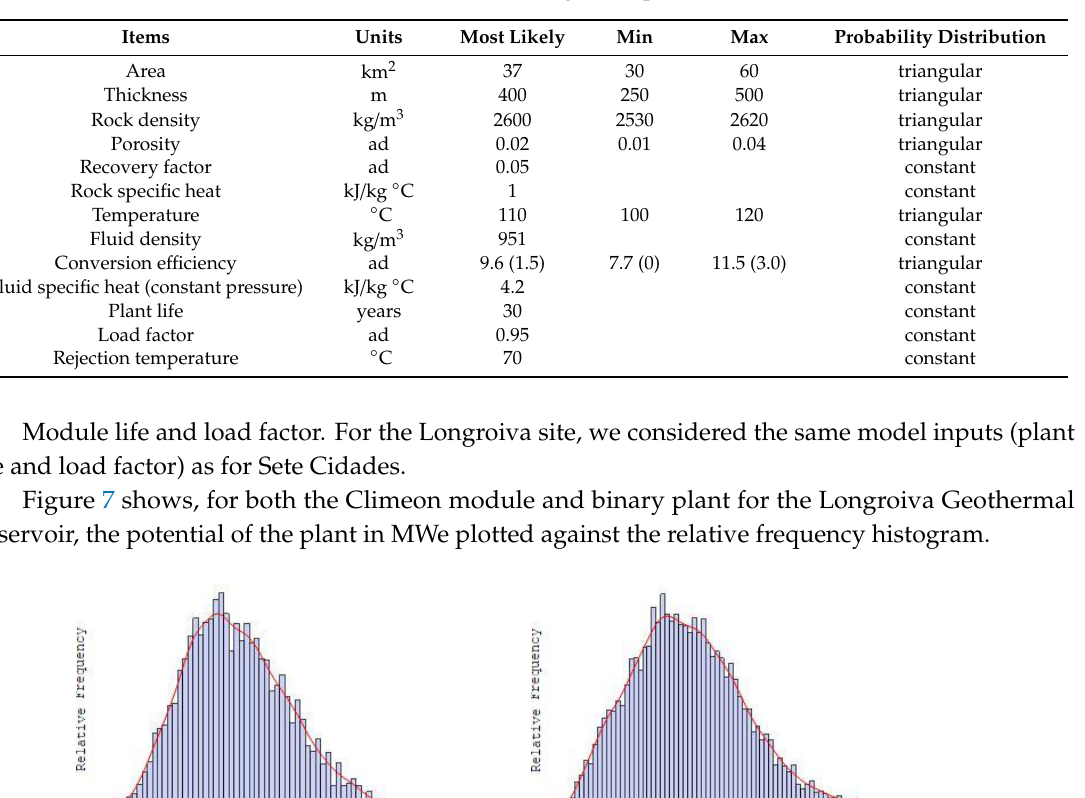
Table 4. Monte Carlo simulation for the Longroiva Spa site (ad = adimensional).